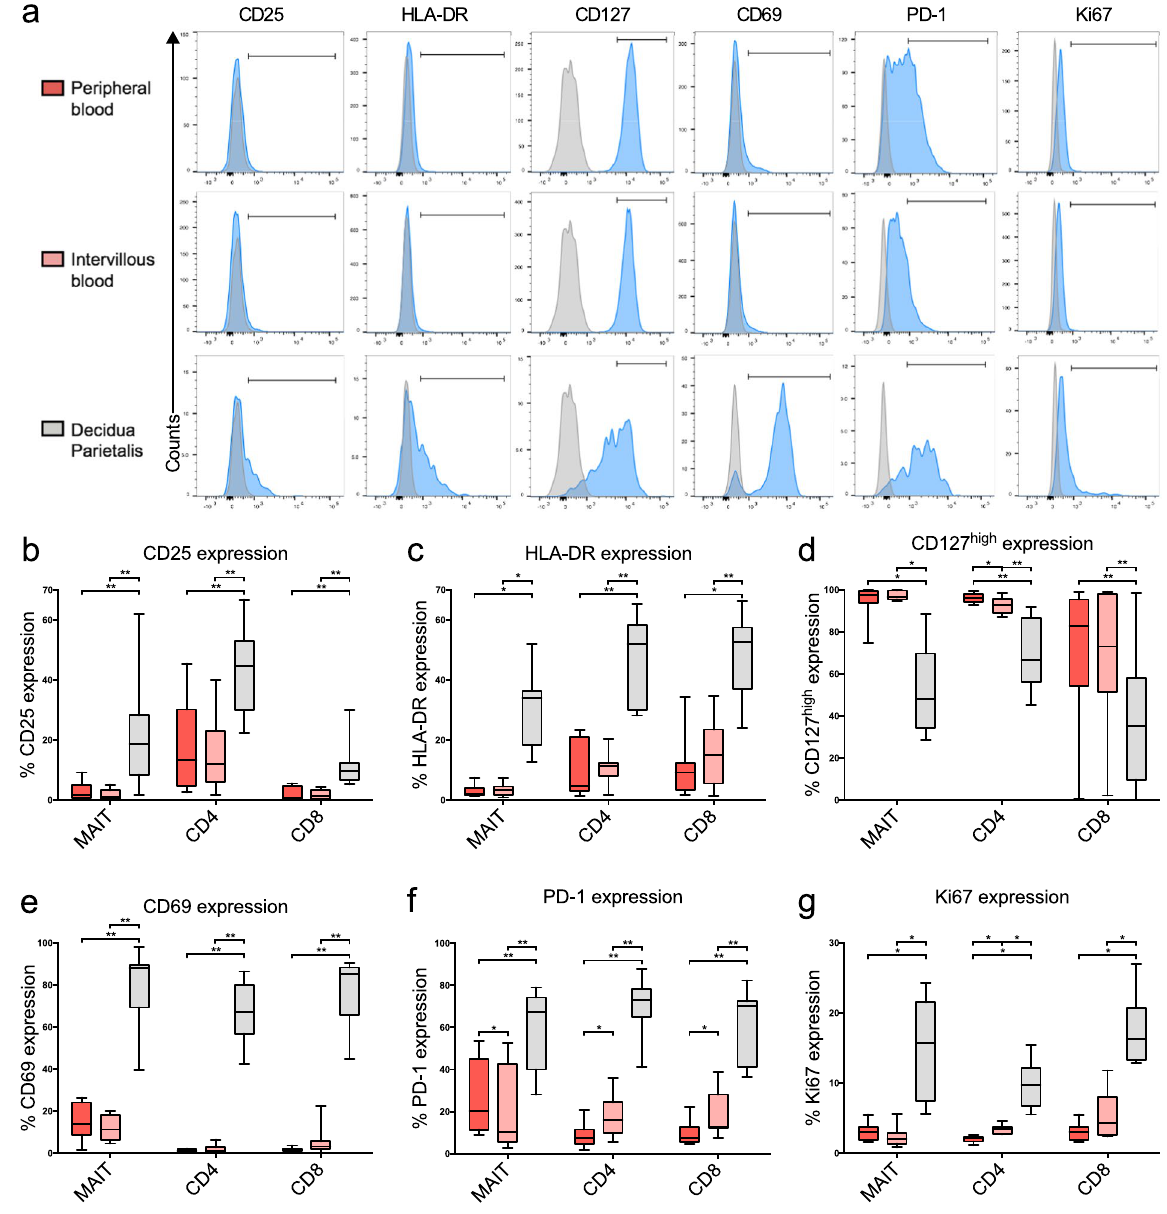
Figure 2. Intervillous blood MAIT cells are not activated, but display a lower PD-1 expression compared to peripheral blood. ( a ) Representative flow cytometry histograms on MAIT cells showing the fluorescent minus one control (grey) and the sample (blue). Bars correspond to the gating strategy which was performed on dot plots. ( b–g ) Comparison between paired samples of peripheral blood (PB) (red), intervillous blood (IVB) (light red), and decidua parietalis (DP) (grey) cells. ( b ) CD25 and ( c ) HLA-DR expression on MAIT cells, CD4 + T cells, and CD8 + T cells ( n = 11). ( d ) CD127 high expression and ( e ) proportion of CD69 MAIT cells ( n = 8), CD4 + T cells ( n = 11) and CD8 + T cells ( n = 11). ( f ) Expression of PD-1 in MAIT cells ( n = 9), CD4 + T cells ( n = 11) and CD8 + T cells ( n = 11). ( g ) Intracellular Ki67 expression in MAIT cells, CD4 + T cells, and CD8 + T cells ( n = 8). Box and whisker plots show median, interquartile range and range of paired samples. The Friedman test followed by the Wilcoxon signed rank test was used to detect statistically significant differences across multiple paired samples ( b – g ). A Bonferroni corrected p value was used. * P < 0.05, ** P <